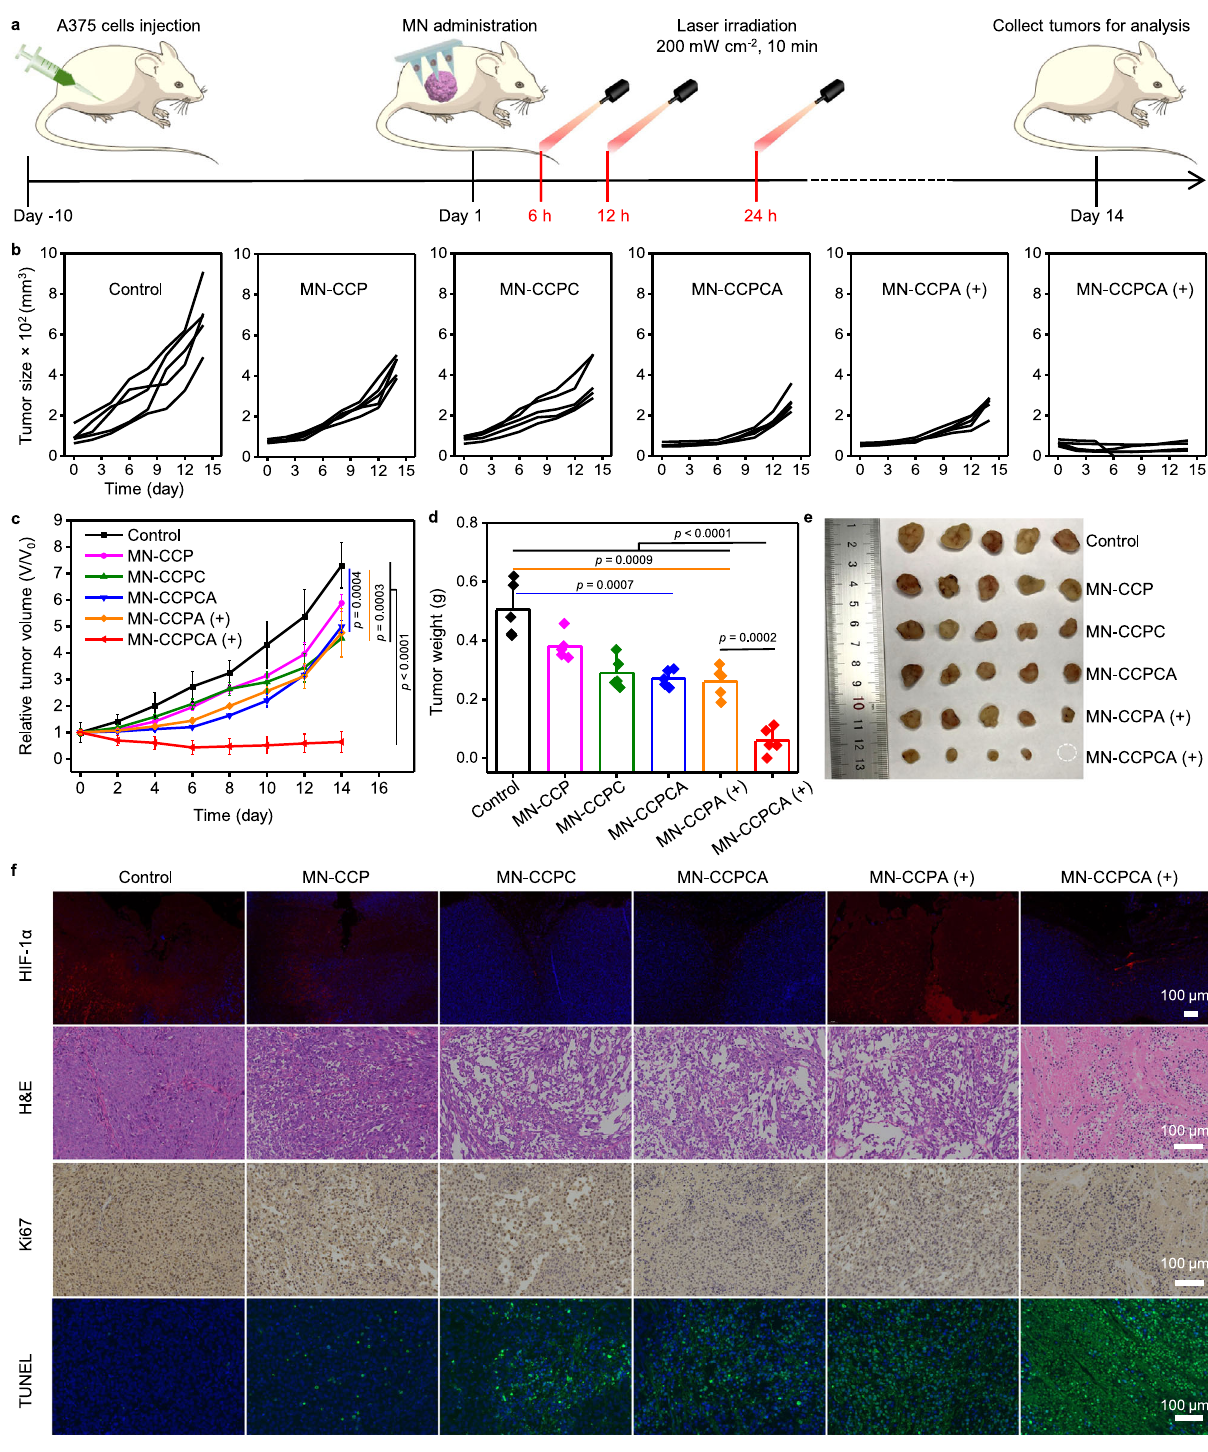
Fig. 6 | The MN-CCPCA patch inhibits tumor recurrence by ion interference- enhancedrepeatable5-ALA-PDT.a ScheduleofthetherapeuticprocessuponFL/ PA duplex imaging navigation. b Individual tumor growth curves and c relative growth curves of A375 tumors in different treatment groups. d Average weight of A375tumorsatthe end ofthetreatmentperiod. Alldata represent the means±SD from fi ve biologically independent female A375 tumor-bearing mice, n =5. Statis- tical signi fi cance was calculated with two-tailed Student ’ s t test. e Photographs of